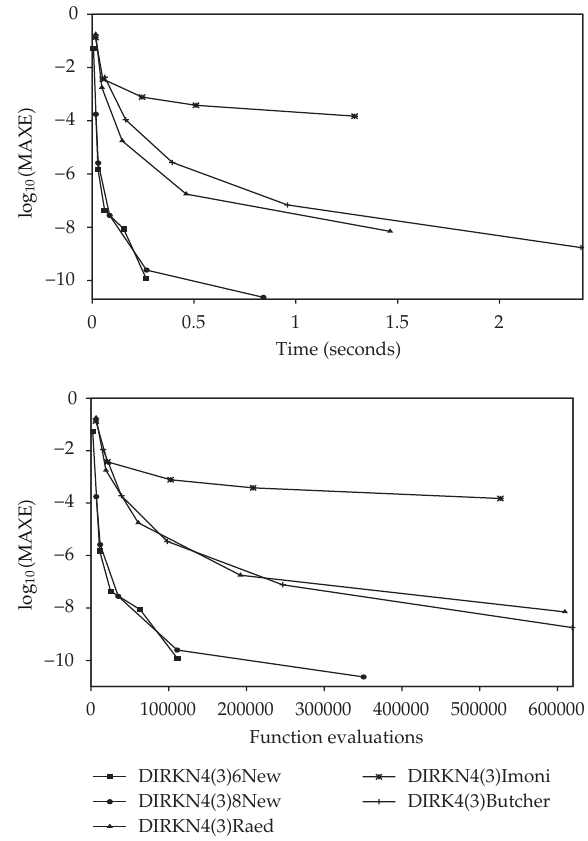
Figure 6: E ffi ciency curves for Problem